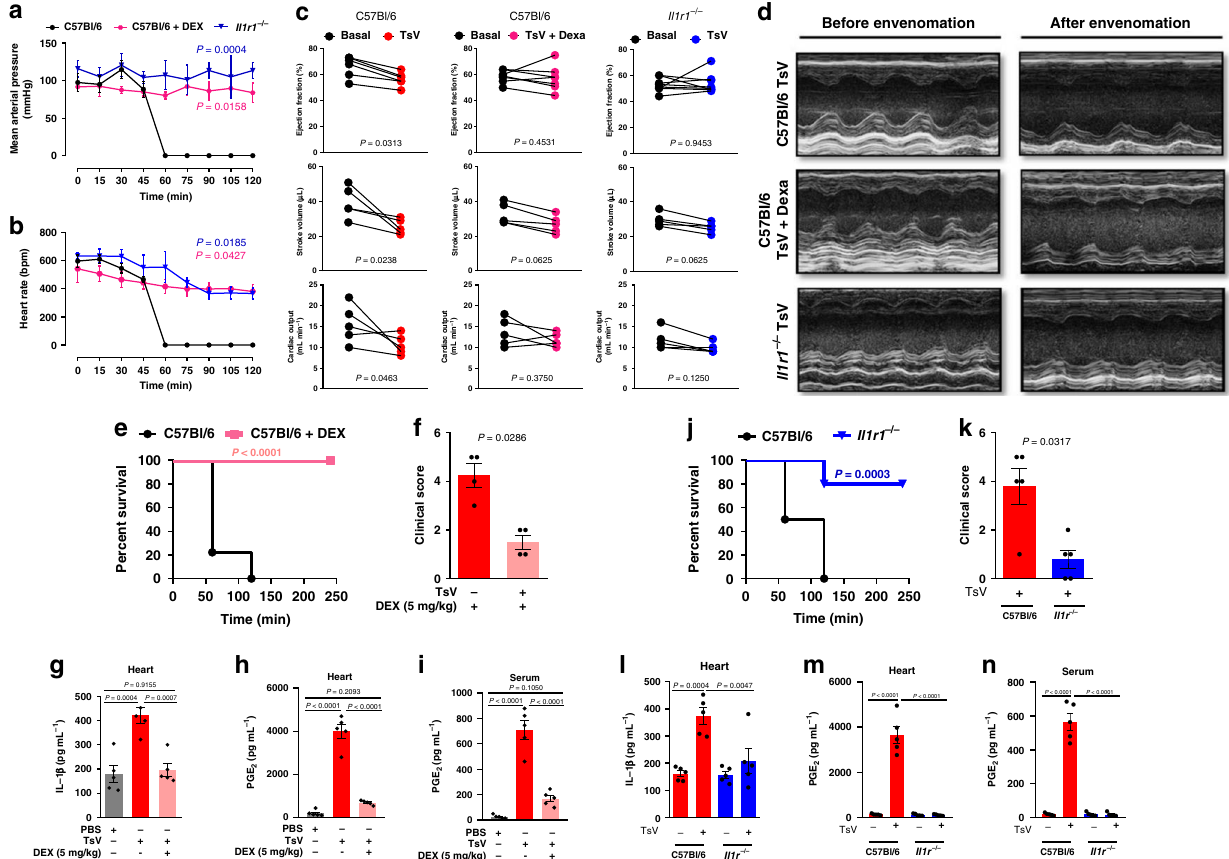
Fig. 3 TsV-induced IL-1 β /IL-1R signaling promotes cardiac dysfunction. a Arterial pressure and b heart rate were recorded in Il1r1 − / − or C57Bl/6 mice, treated or not with DEX, and challenged i.p. with a lethal dose of TsV ( n = 4 – 5, one experiment). Envenomed mice had their echocardiography examination performed for 15 min, starting 45 min after envenomation and ending 60 min after TsV. c Ejection fraction (EF), stroke volume (SV), and cardiac output (CO) ( n = 5 – 6, one experiment). d Representative M-mode image of echocardiographic examination of the left ventricle before and 45 min after inoculation with TsV in Il1r1 − / − or C57Bl/6 mice, treated or not with DEX. e Survival curves ( n = 10, one representative of two experiments), f clinical score ( n = 5, one representative of two experiments), g IL-1 β , and h PGE 2 concentration in heart homogenates ( n = 5, one experiment), and i PGE 2 in the serum